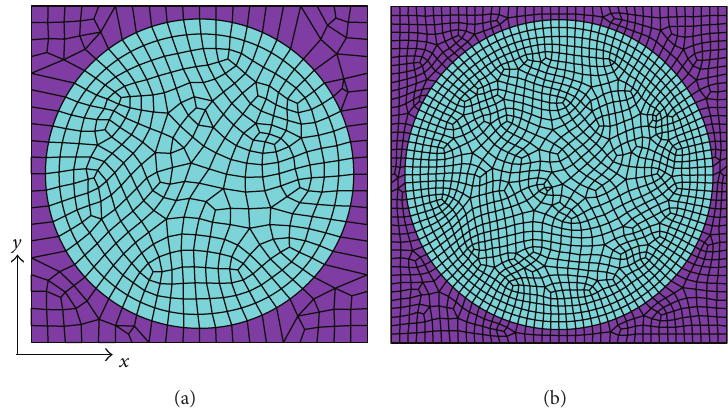
Figure 2: Different meshing density when volume fraction is 0.666. The RVE edge line is set into (a) 20 and (b) 40 divisions.